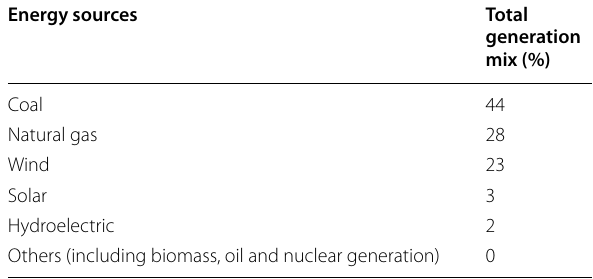
Table 4 Power supply mix for Colorado